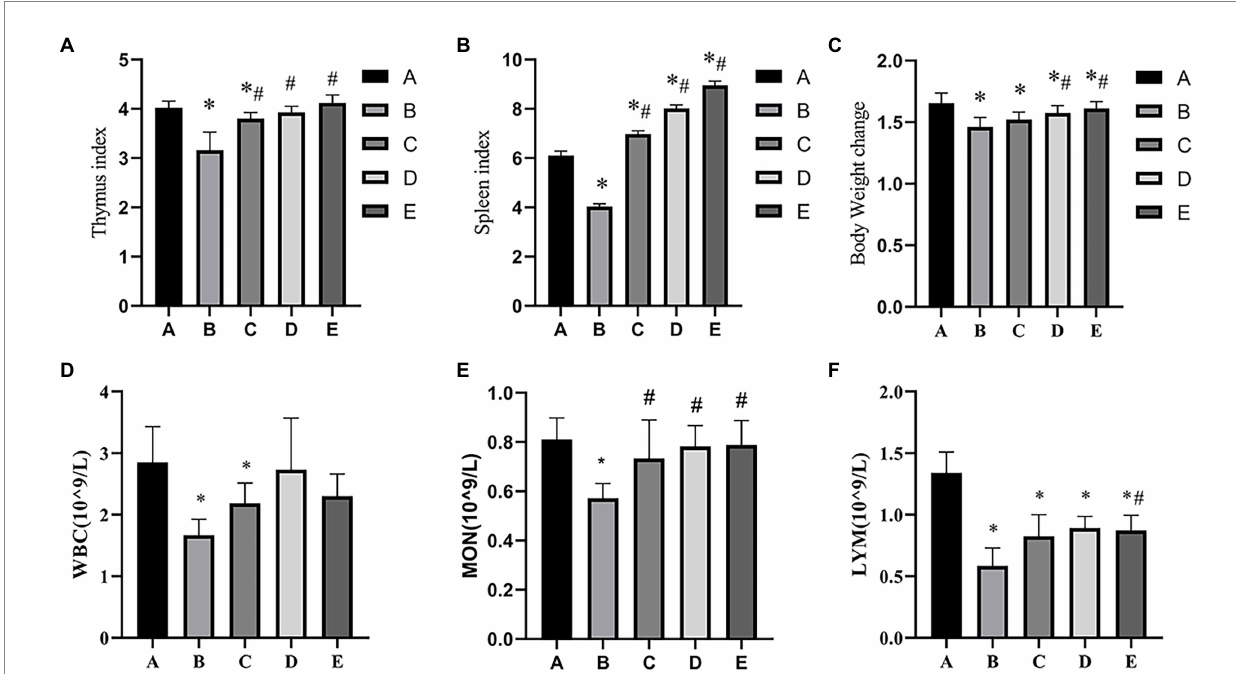
FIGURE 1 Effects of CSPCM on immune organ indexes and body weight change in mice. (A) Effects of CSPCM on thymus index in mice. (B) Effects of CSPCM on spleen index in mice. (C) Effects of CSPCM on body weight change on mice. (D) Effects of CSPCM on WBC number in mice. (E) Effects of CSPCM on MON number in mice. (F) Effects of CSPCM on the percent of LYM in mice. *: significant difference with group A ( p < 0.05), # significant difference with group B ( p < 0.05), same as below.